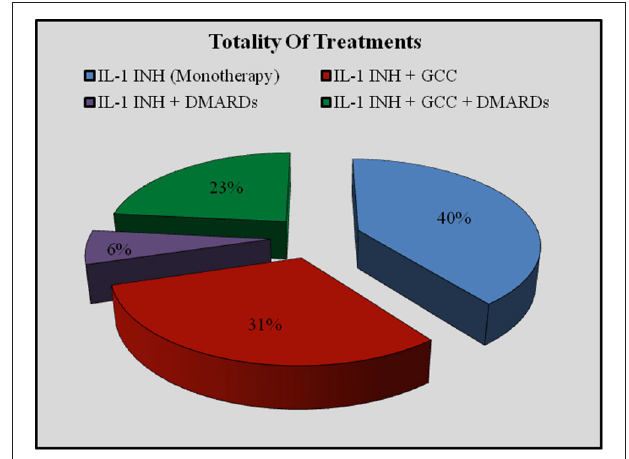
FIGURE 2 | Use of concomitant therapies during IL-1 inhibition on the whole of treatment courses. DMARDs, disease modifying antirheumatic drugs; GCC, glucocorticosteroids; IL-1-INH, IL-1 inhibitors.